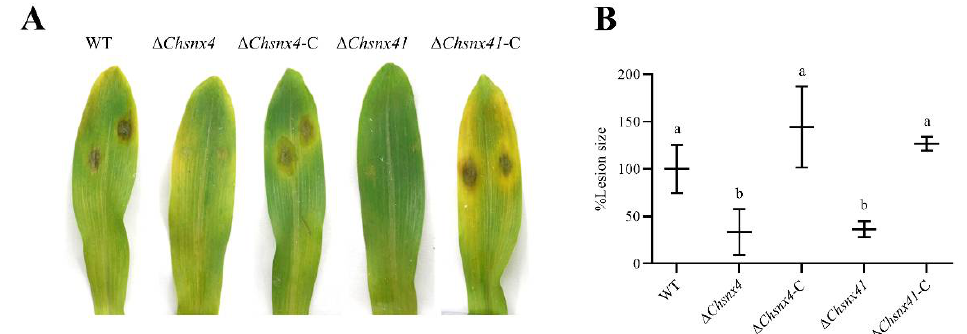
Figure 7. Virulence of WT, mutants, and complemented strains on maize. ( A ) Inoculation with co- nidia droplets of each strain on detached, susceptible Zea mays “B73” leaves. ( B ) Lesion size of the indicated strains on detached maize leaves. Each experiment had three replicates and was repeated three times.